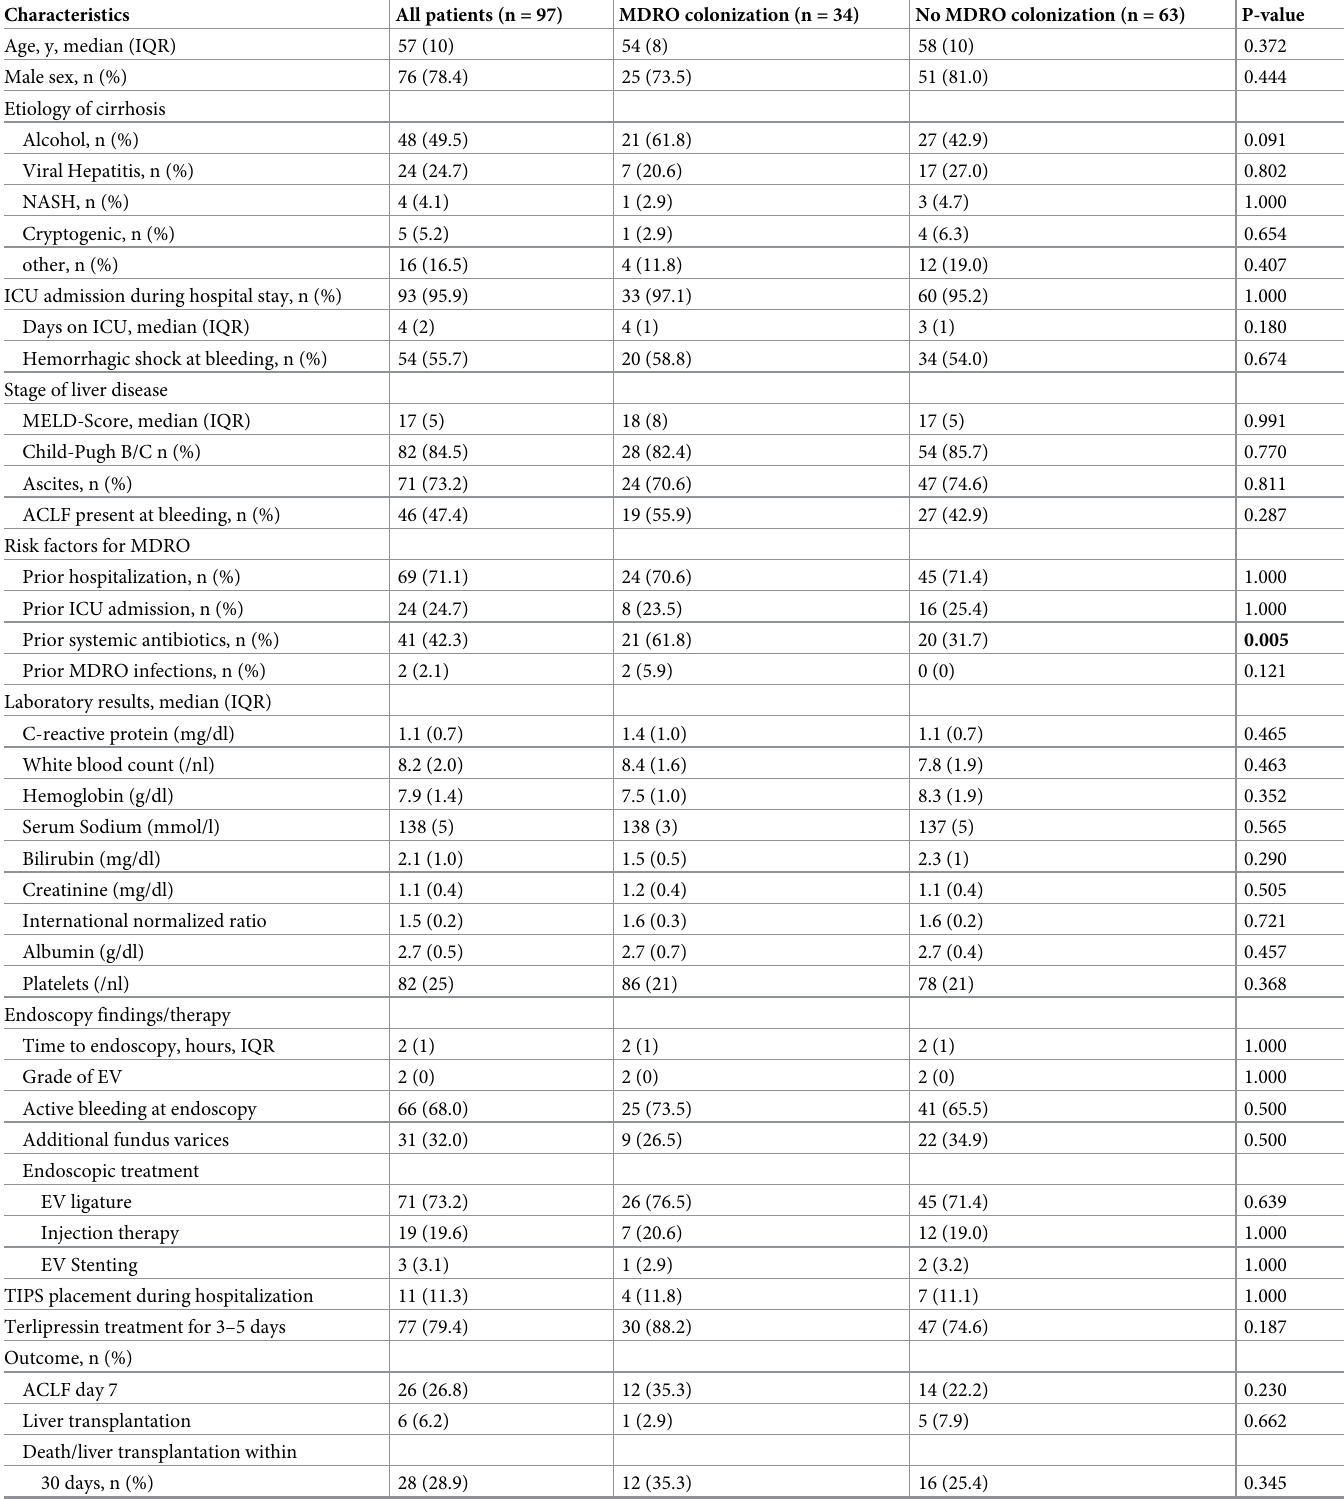
Table 1. Patients’ characteristic for patients stratified according to baseline MDRO colonization.